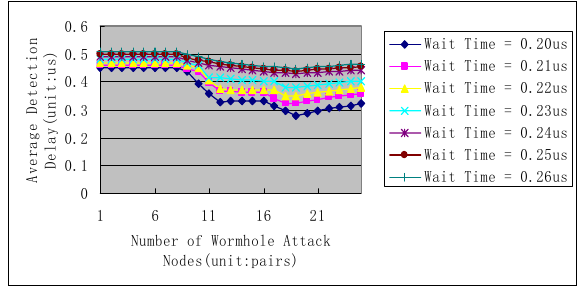
Fig.10. Average Detection Delay for Different Wait Times Fig.10 shows the average detection delay for different numbers of wormhole attackers as well as for Fig.11. Detection Success Rate for Different Wait